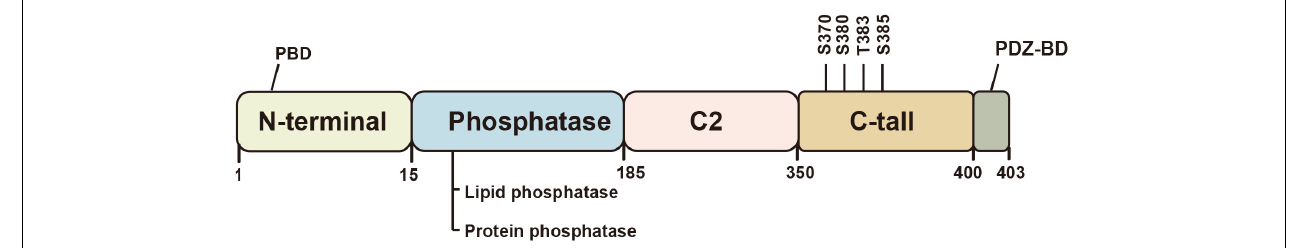
FIGURE 1 | Schematic illustration of the structure of the PTEN protein. PTEN is a tumor suppressor with five functional domains: N-terminal phosphatidylinositol (Ptdlnsf4, 5) P2-binding domain (PBD), a phosphatase domain, a C2 lipid or membrane-binding domain, a carboxy-terminal tail, and a class I PDZ-binding (PDZ-BD) motif. The protein function largely depends on its lipid phosphatase and protein phosphatase activity. The C2 domain or C-terminal tail regulates the protein activity and